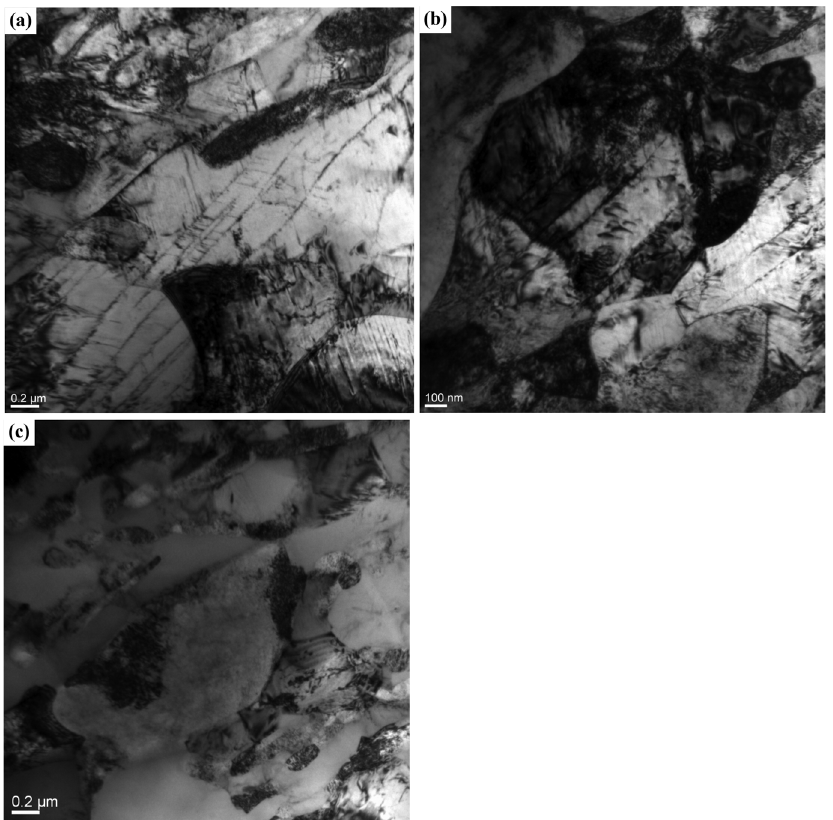
Figure 15: TEM observation of the defor- mation microstructure: (a) and (b) dislo- cation glide; (c)